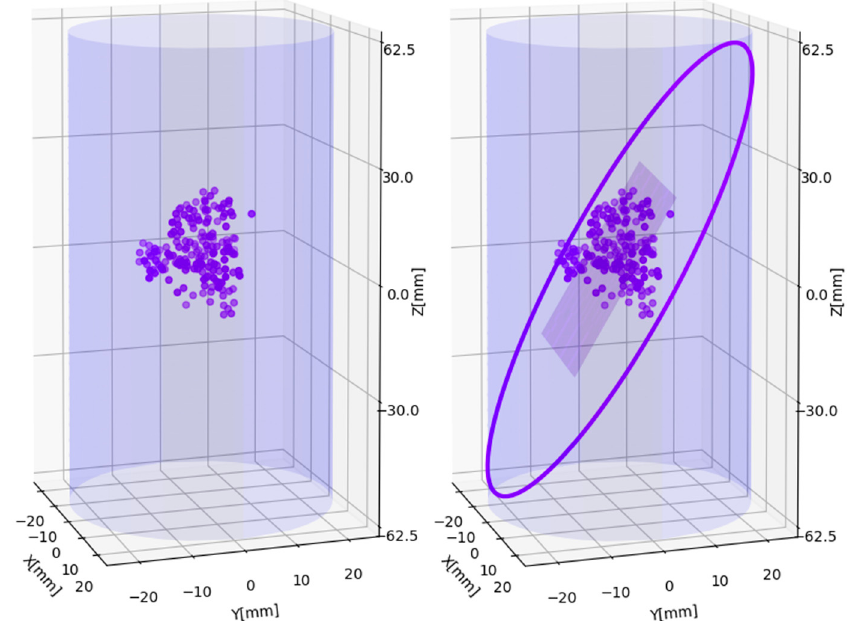
Figure 18. This figure is about the main cluster. The extracted main cluster is shown in figure ( a ) and figure ( b ) is the main fracture plane recognition result.